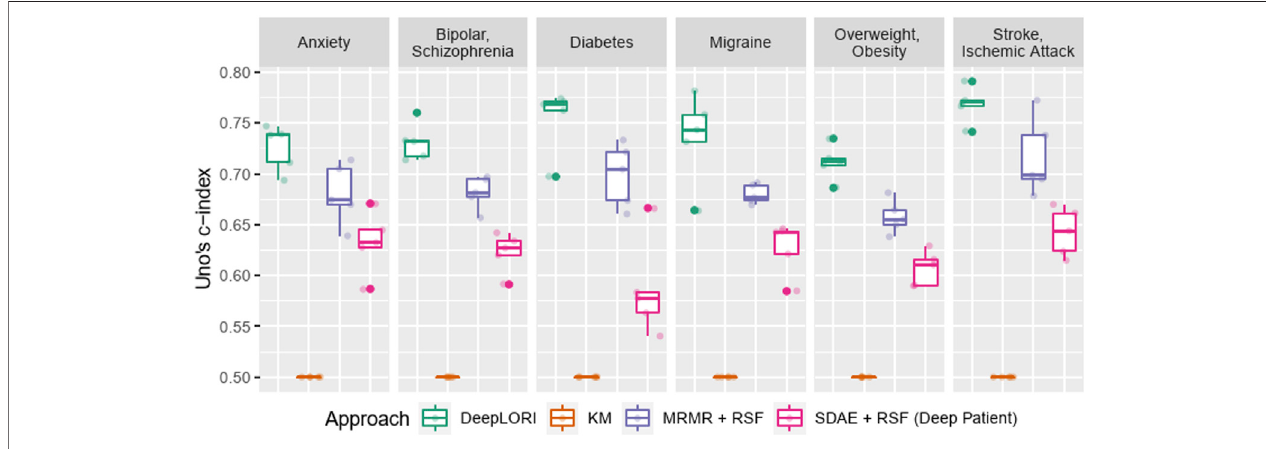
FIGURE 3 | Five-fold (nested) cross-validation test sets performance benchmark of Deep LORI (green) vs. competing methods; mRMR: minimum redundancy maximum relevance feature selection; SDAE: stacked denoising autoencoder; RSF: random survival forest; KM: Kaplan – Meier